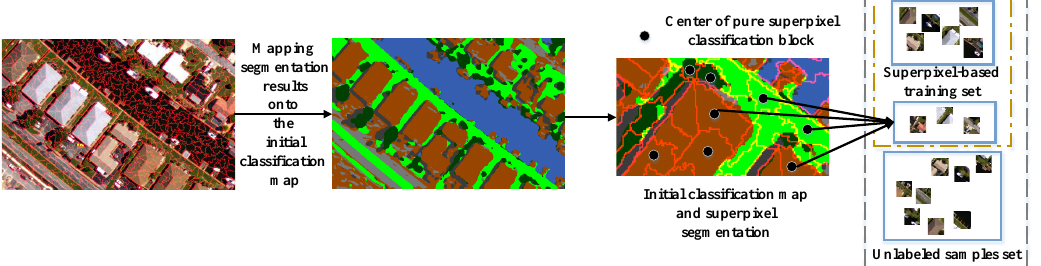
Figure 4. Superpixel-based sample selection. Segment the VHR image with superpixel segmentation, and the center pixel of superpixel with “pure” classification is selected to enlarge the training set.